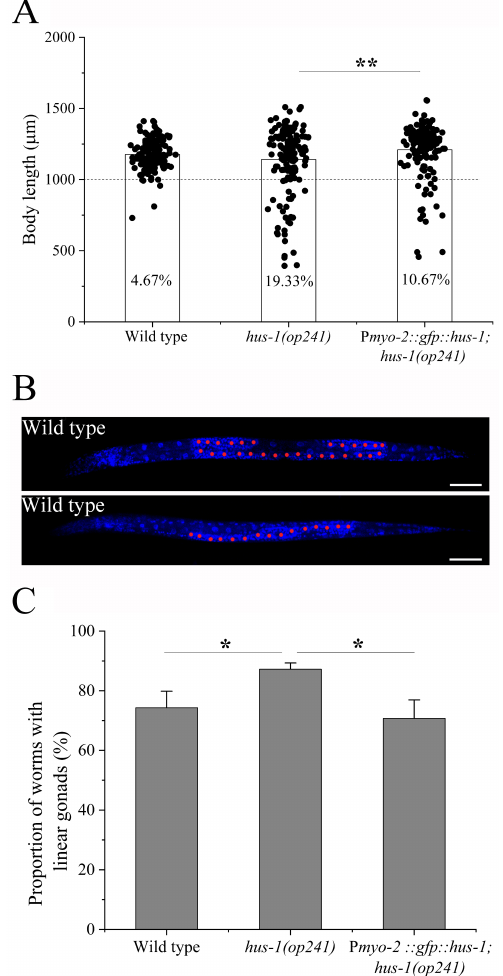
Figure 6. Systemic regulation of pharyngeal ATR cascade on worm growth and development: ( A ) body length of adult worms BPL1121: P myo-2::gfp::hus-1; hus-1(op241) after γ -irradiation ( n = 150), and the numbers in datum bars are the percentage of worms with body length of less than 1 mm.; ( B ) N2 worms with U-shaped (top) and linear (bottom) gonads, scale bar: 50 µ m; ( C ) the proportion of worms with linear gonads at 32 h after γ -irradiation. Results are means ± SD ( n ≥ 3, t -test, nonparametric test for panel A, * p < 0.05, ** p <